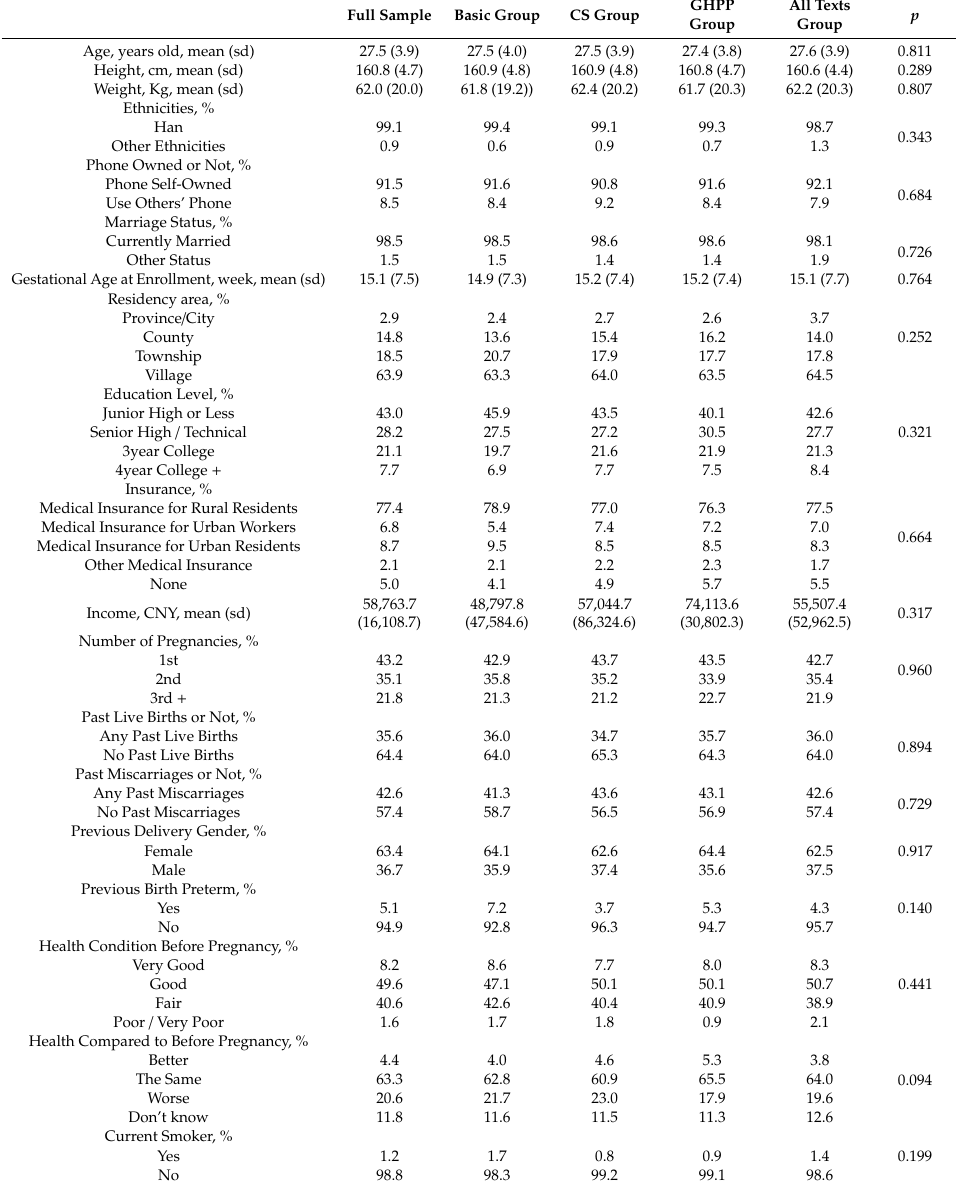
Table 2. Summary Statistics and Balance